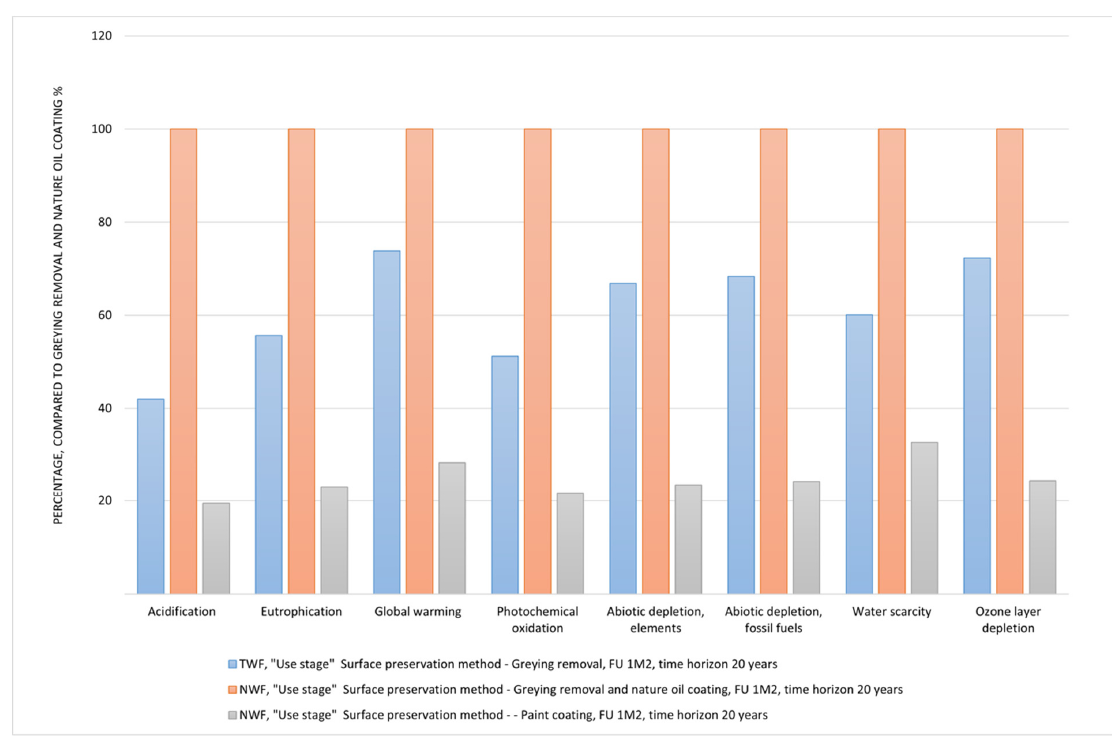
Figure 6. “Use stage” for the functional unit (FU) (1 m 2 ) of TWF with selected surface treatments and NWF with selected coatings; time horizon 20 years. Method EPD (2018) V1.01. TWF—thermally modified wood façade, NWF—non-heat-treated wood façade.